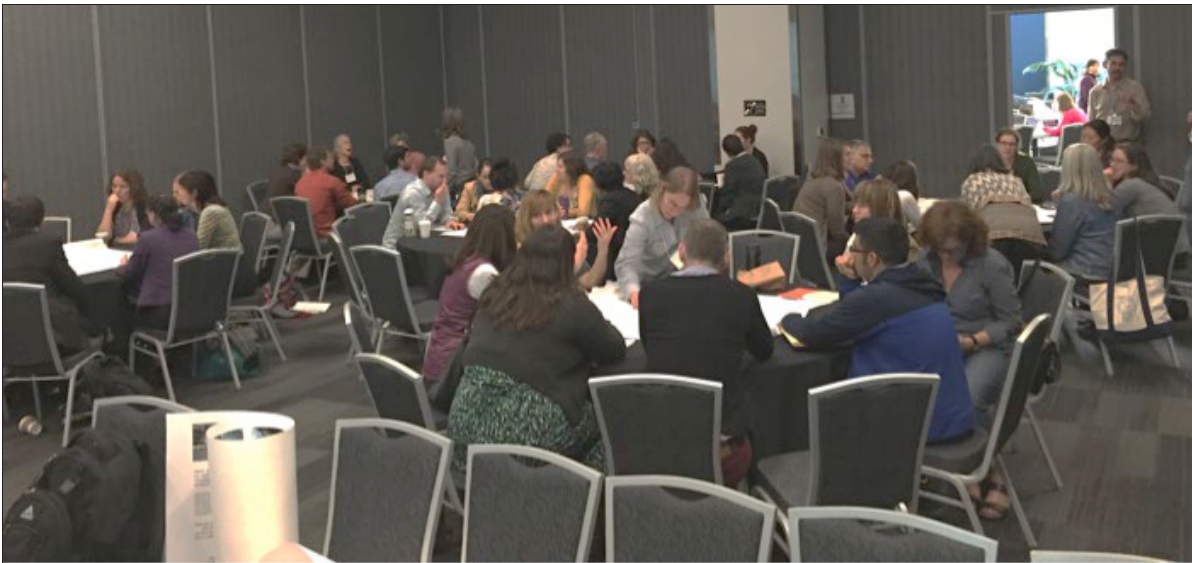
Figure 1: The Partnerships symposium world café in